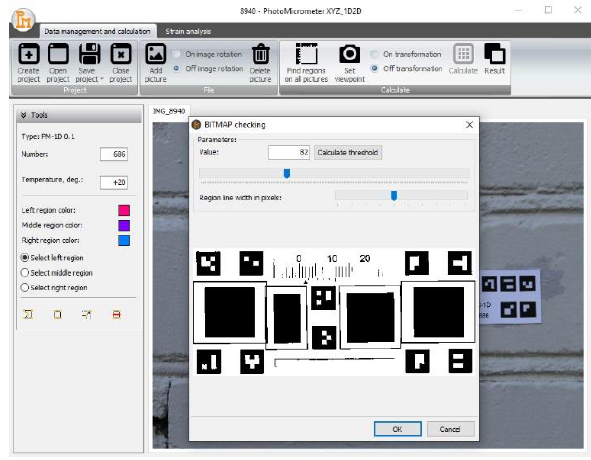
Figure 6. Finding measuring areas and counting the number of black pixels in them.